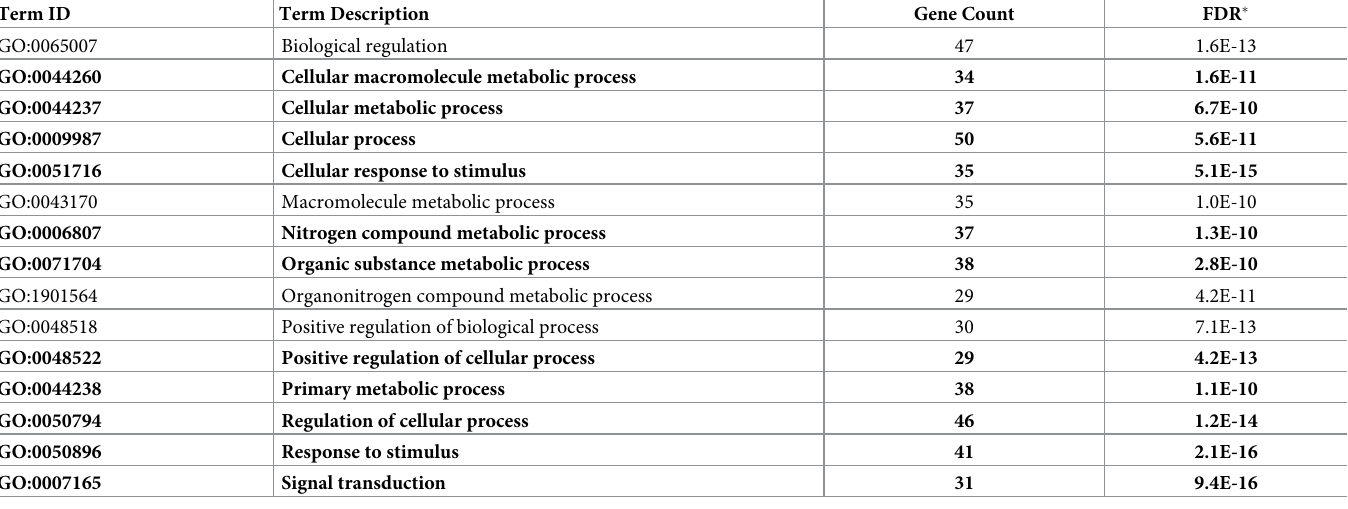
Table 1. GO biological processes in the